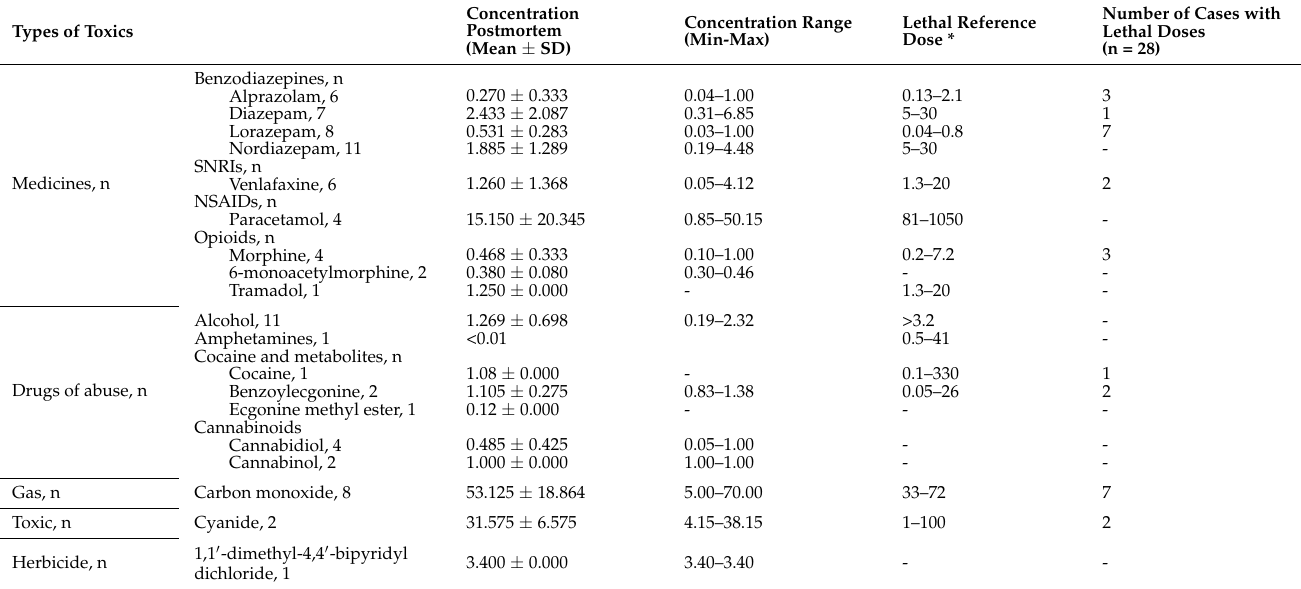
Figure 5. Representative scheme of the different toxics found in the autopsy according to the suicide mechanism. The size of the box for each toxic represents its frequency of presence in the autopsies. Table 5. Analysis of concentrations of the different toxics in drug overdose